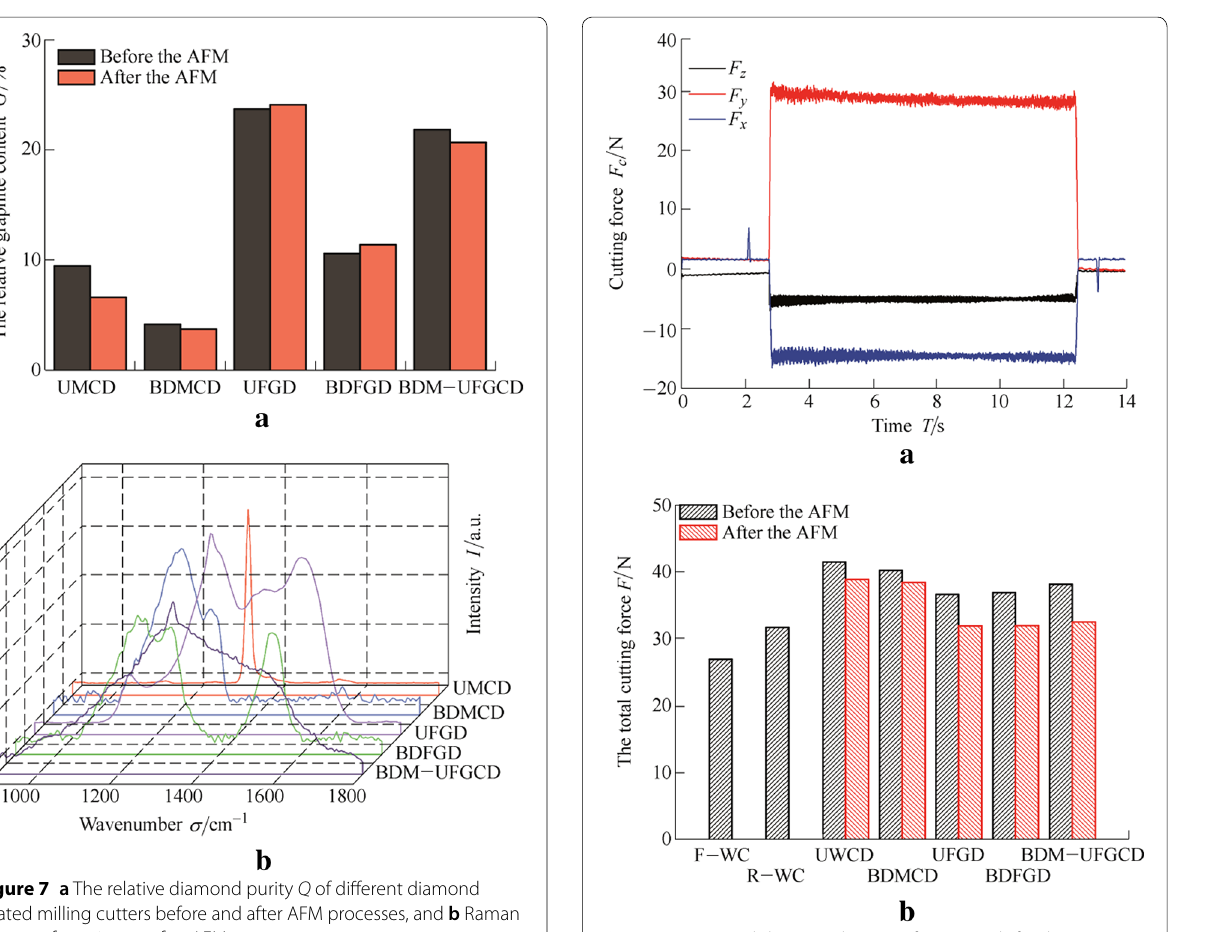
AFM‑BDM‑UFGCD specimen after the lowpass filtering and b total cutting forces for all the specimens, at initial stages of the milling